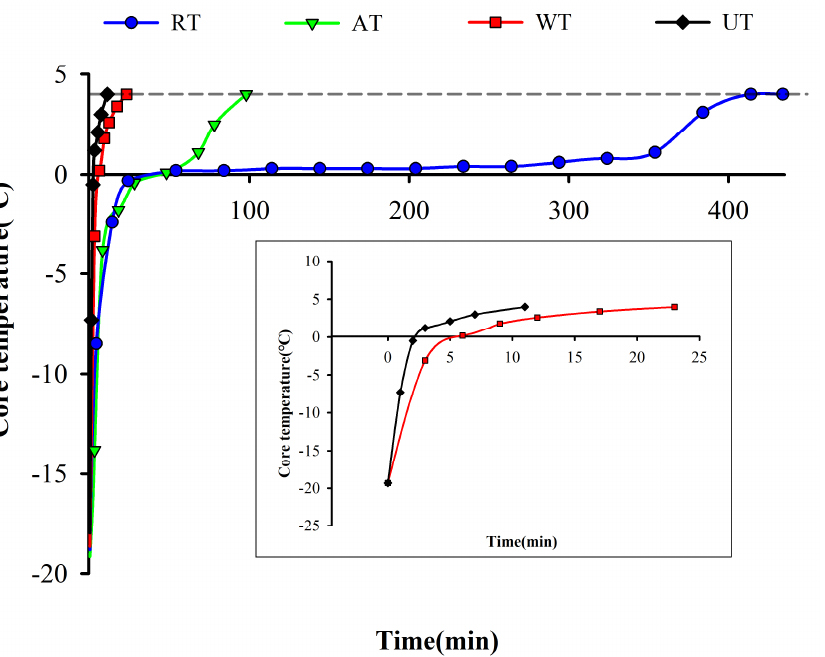
Figure 1. The time-temperature curves of instant sea cucumbers subjected to four thawing methods. In the gray box, we present the thawing curves for WT and UT from 0 to 25 min. RT, refrigerator thawing; AT, air thawing; WT, water immersion thawing; UT, ultrasonic-assisted thawing. The abbreviations of thawing methods are the same below.